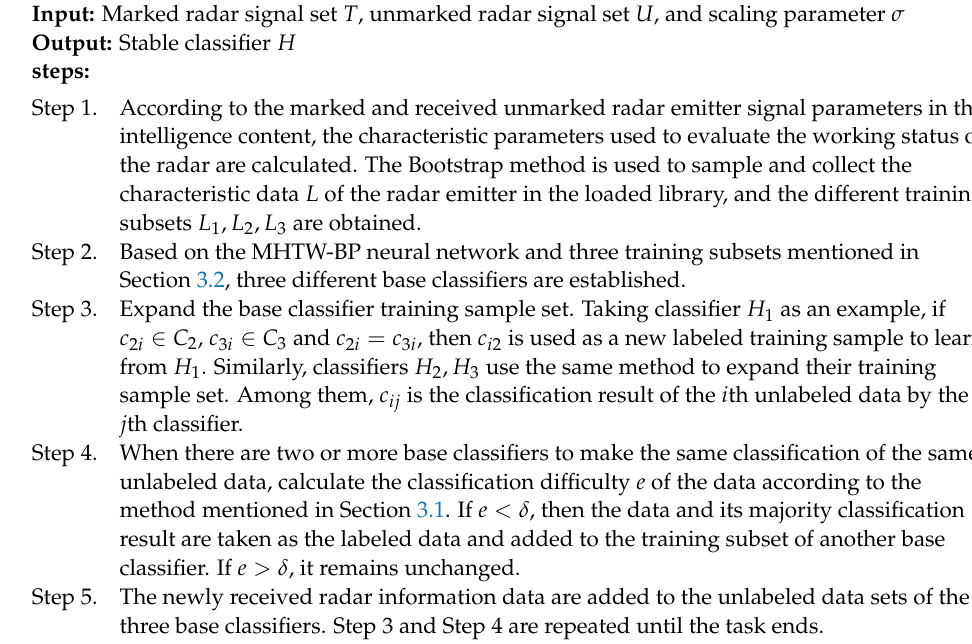
Algorithm 2: Improved Tri-Training Algorithm